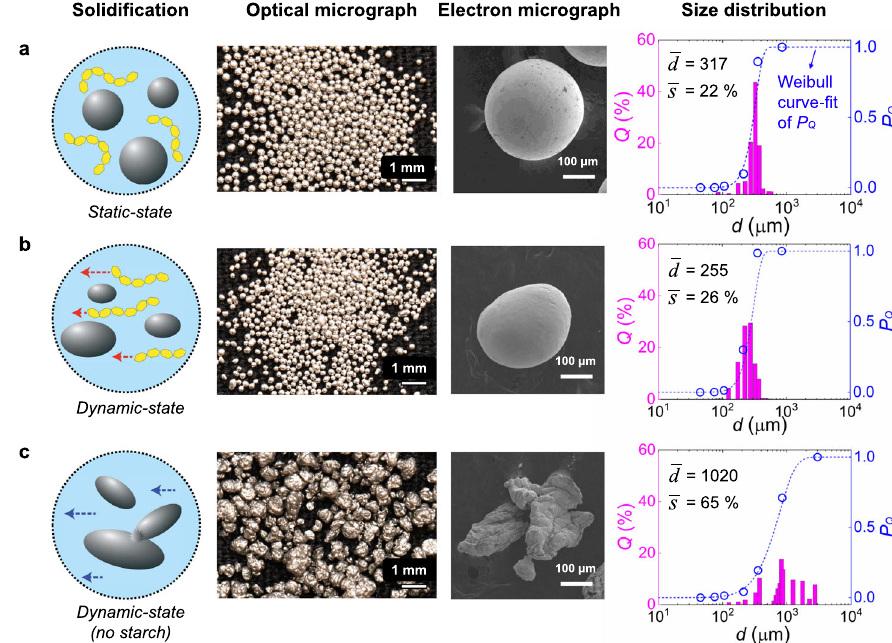
Fig. 2 Field ’ s Metal particles fabricated under different conditions. a Static-state process in starch/water medium is devoid of any external force or internal particle coalescence during the solidi fi cation stage. Produced solid particles preserve the spherical shape of the emulsi fi ed droplets, and the particle size distribution is narrow with the mean particle diameter (cid:1) d = 317 μ m with the standard deviation (cid:1) s = 22%. The particle size distribution is shown in the volume fraction, Q achieved from the image analysis, or in the cumulative mass, P Q achieved from the sieve analysis. b Dynamic-state process in starch/ water medium mitigates internal particle coalescence but the continued shear force results in deformed particle shapes. c Dynamic-state process in water medium gives rise to both particle deformation and coalescence, resulting in particles with irregular shapes and a wide size distribution of (cid:1) s =